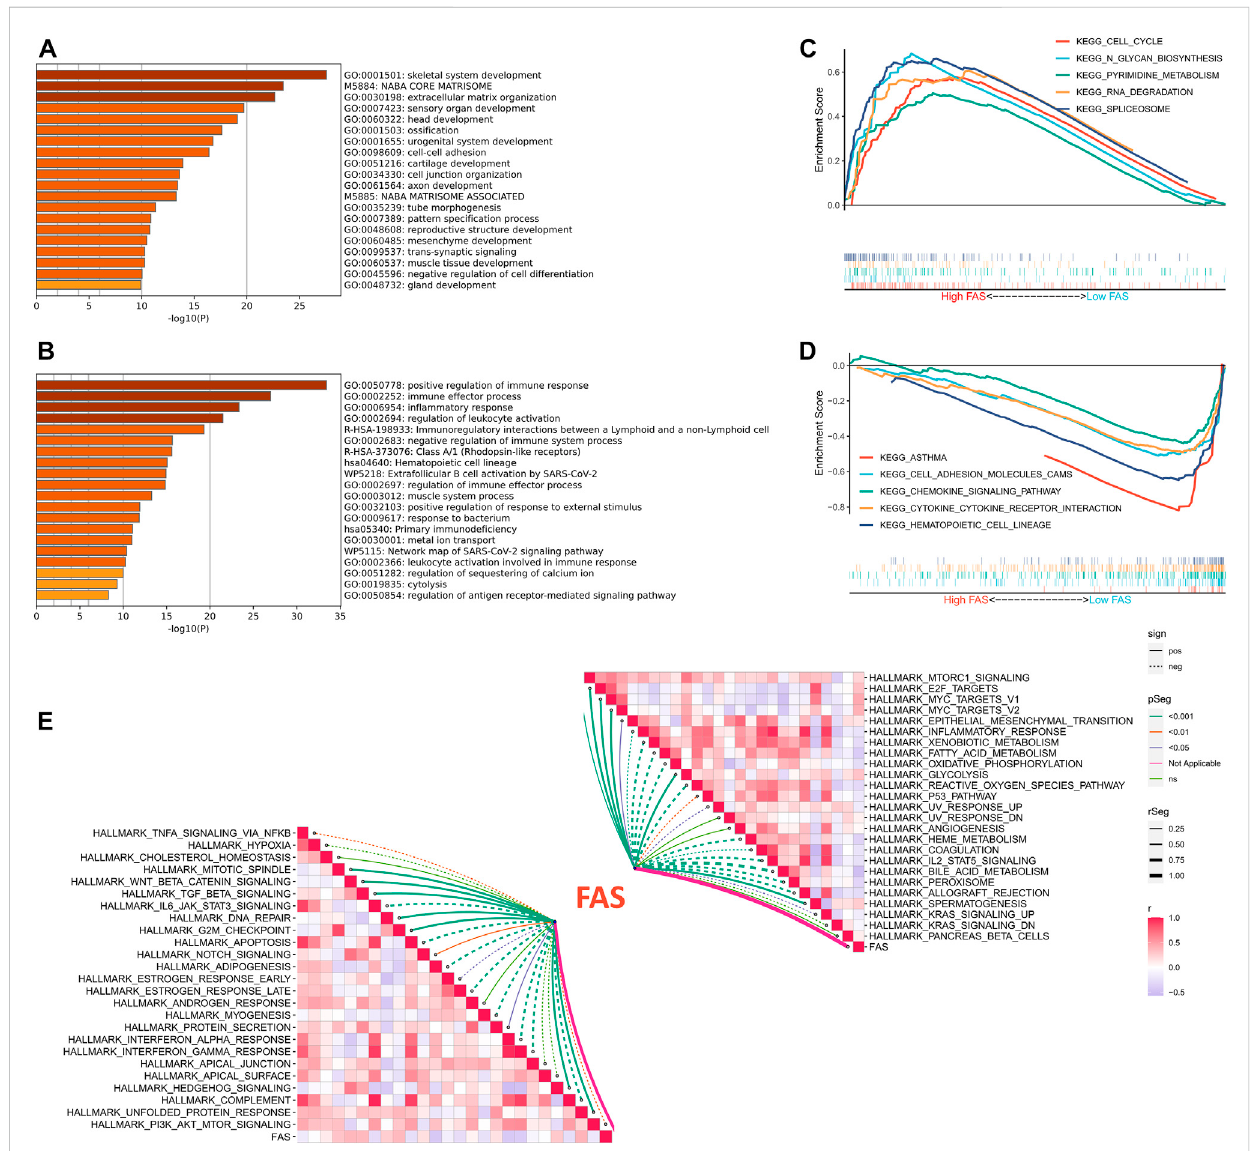
FIGURE 5 Functional analysis of FAS in STS. (A,B) GO enrichment analysis results for the low- and high-FAS groups in the TCGA-STS cohort. (C) The GSEA results of the high-FAS group in the TCGA-STS cohort. (D) GSEA results of the low-FAS group in the TCGA-STS cohort. (E) The association of FAS with molecular markers in the TCGA-STS